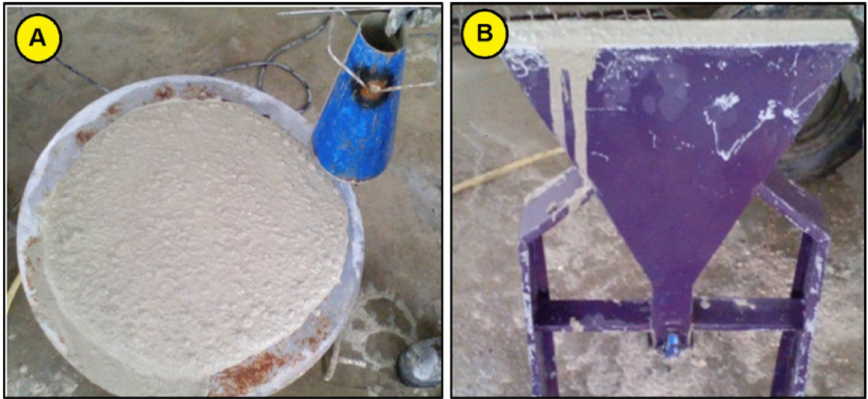
Figure 9. Experiments on fresh concrete: ( A ) slump flow test apparatus; and ( B ) V-funnel test apparatus. Reproduced from